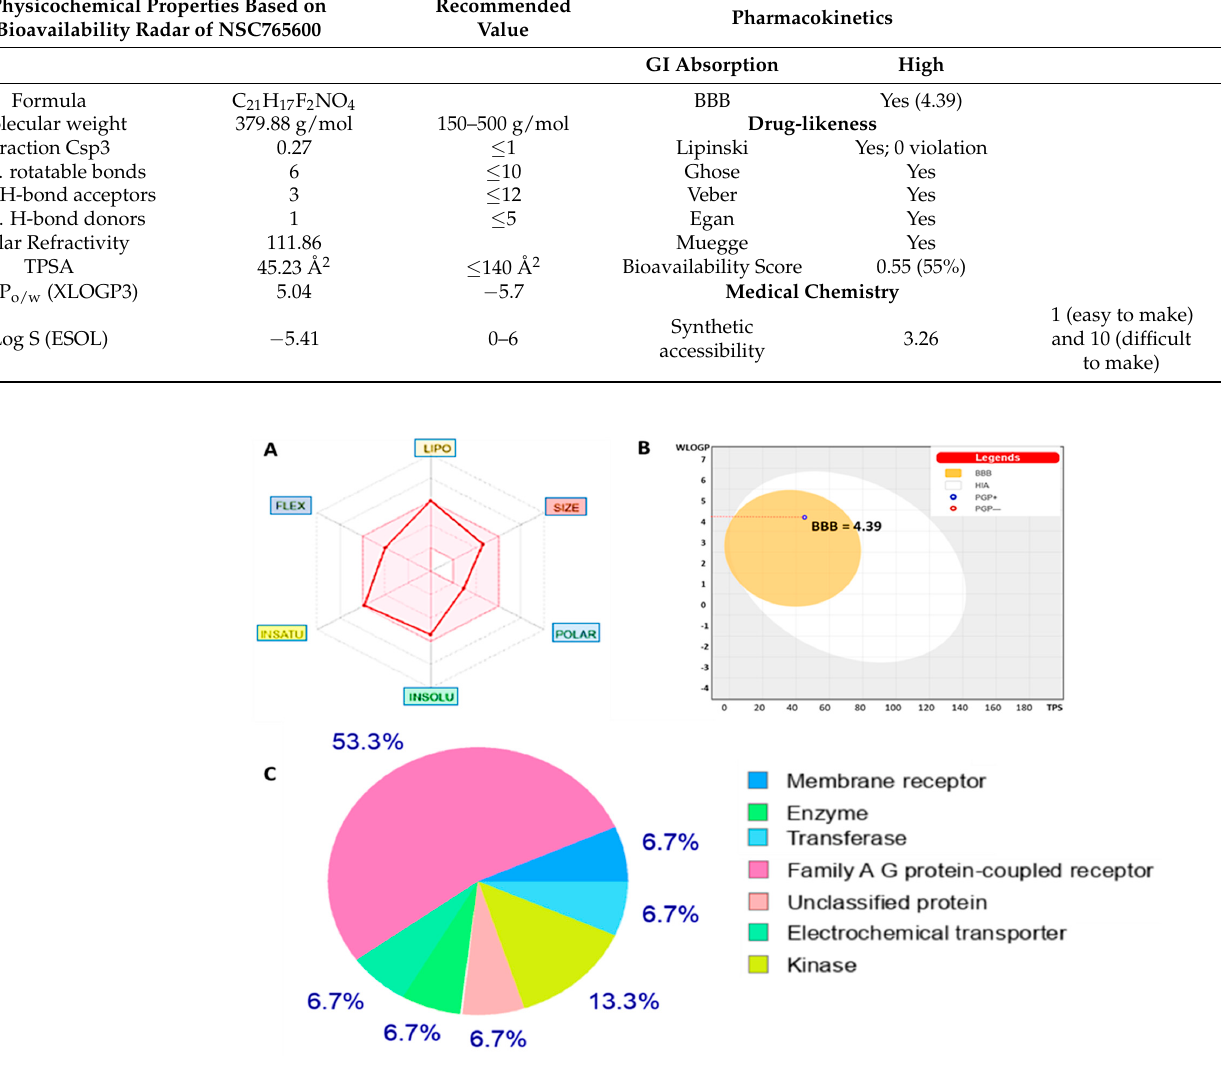
Figure 10. NSC772864 passed the required physicochemical properties, medicinal chemistry, pharmacokinetics (PKs), and drug-likeness criteria. ( A ) Structure of the NSC772864 small molecule, bioavailability (BA) radar, displaying the six physicochemical properties of absorption including lipophilicity (XLOGP3 = 5.04), molecular weight (379.88 g/mol), polarity (PSA = 45.23 Å 2 ), solubility (Log S (ESOL) = − 5.41), flexibility (rotation = 6), saturation (fraction Csp3 = 0.27), and pKa of the most basic or acidic group (=0.6) of the NSC772864 compound. In addition, the NSC772864 compound demonstrated a highly probable gastrointestinal absorption (GIA), BA score (55%), and good synthetic accessibility (3.26). ( B ) The compound passed the blood–brain barrier (BBB) assessment with a score of 5.98 and further displayed a drug-like model score of − 0.48. A structural characterization of the compound was performed with the help of spectroscopic studies including IR, proton NMR, 13C NMR, MS, and an elemental analysis ( C ). Pie chart showing targetable protein candidates for NSC772864 (Table 2). Results are shown of the physiochemical properties, pharmacokinetics, drug-likeness, and medical